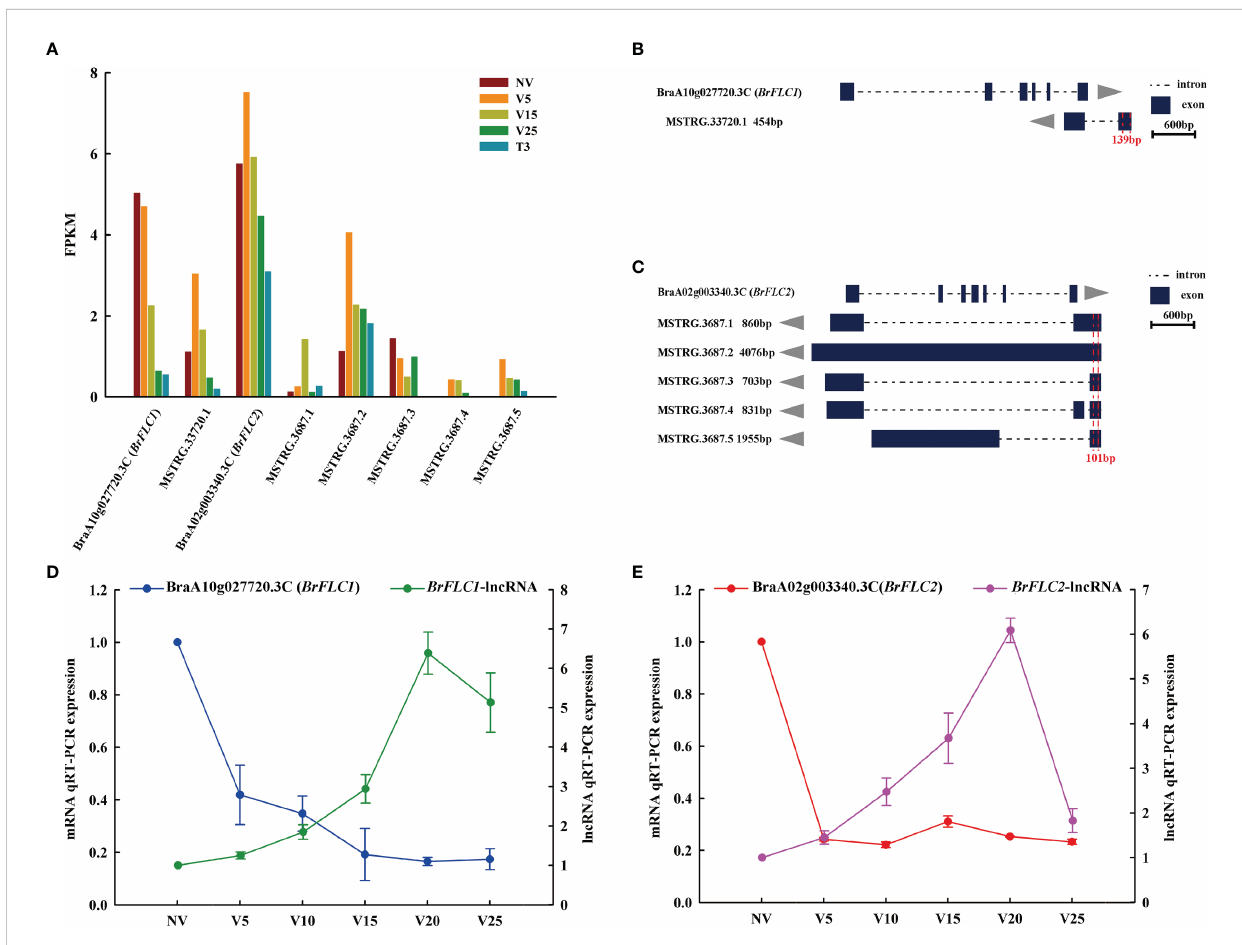
FIGURE 9 Analysis of lncRNAs and their target FLC genes. (A) FPKM values of lncRNAs and their target FLC genes in the sequenced samples. (B) Schematic diagram of the genomic location and transcription direction for lncRNAs and their target FLC1 gene. Speci fi c primers (red dotted line overlapping regions) were designed for qRT-PCR. (C) Schematic diagram of the genomic location and transcription direction for lncRNAs and their target FLC2 gene. Speci fi c primers (red dotted line overlapping regions) were designed for qRT-PCR. (D) Relative expression levels of anti-function lncRNAs and their target FLC1 gene in all plumule-vernalization samples. Data are presented as the mean ± standard error (SE). (E) Relative expression levels of anti-function lncRNAs and their target FLC2 gene in all plumule-vernalization samples. Data are presented as the mean ± standard error